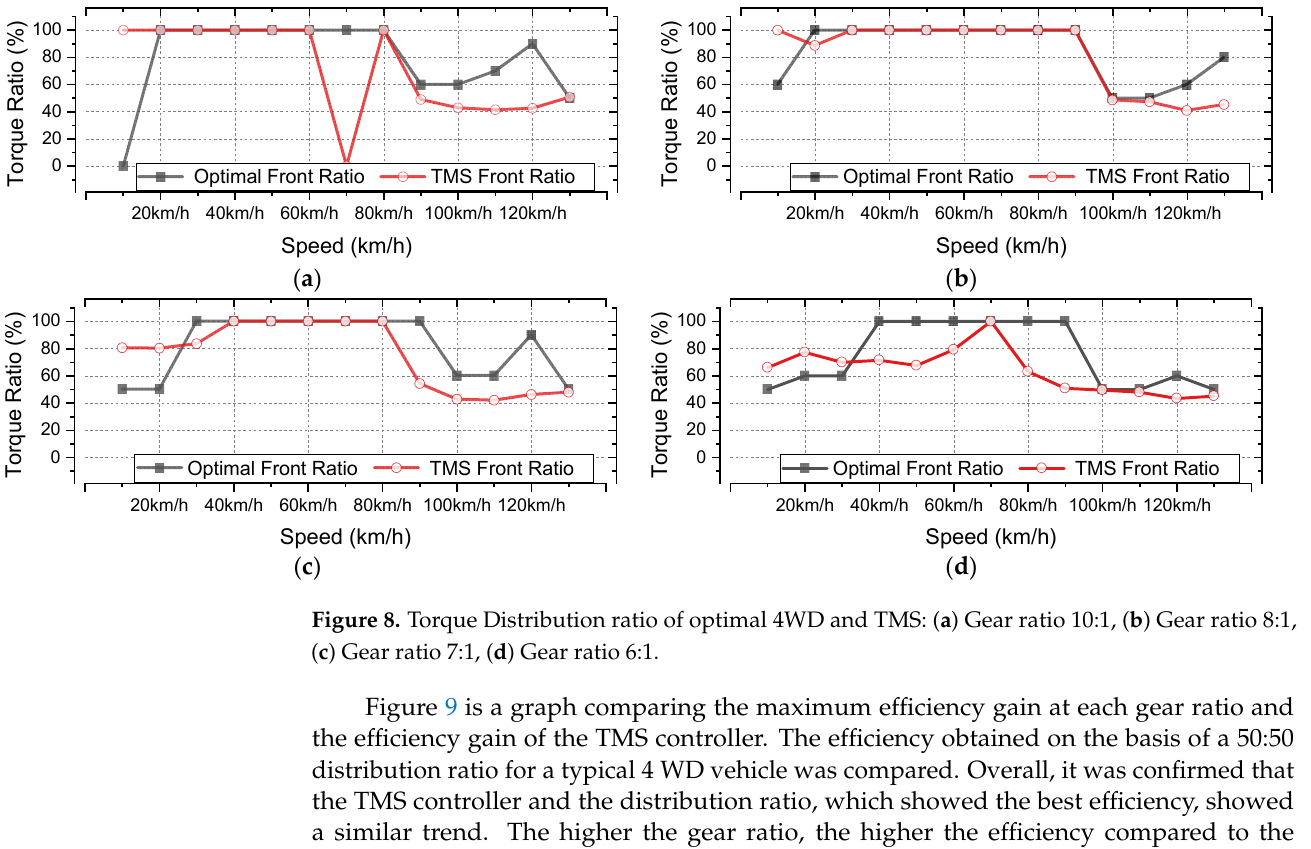
( d ) Figure 9. Efficiency gains versus conventional 4 WD: ( a ) Gear ratio 10:1 ( b ) Gear ratio 8:1 ( c ) Gear ratio 7:1 ( d ) Gear ratio 6:1. In Chapter 3, the driving points of the 4 WD and TMS controllers were compared through an EDR constructed for vehicle design. Figure 10 is a DER graph derived through